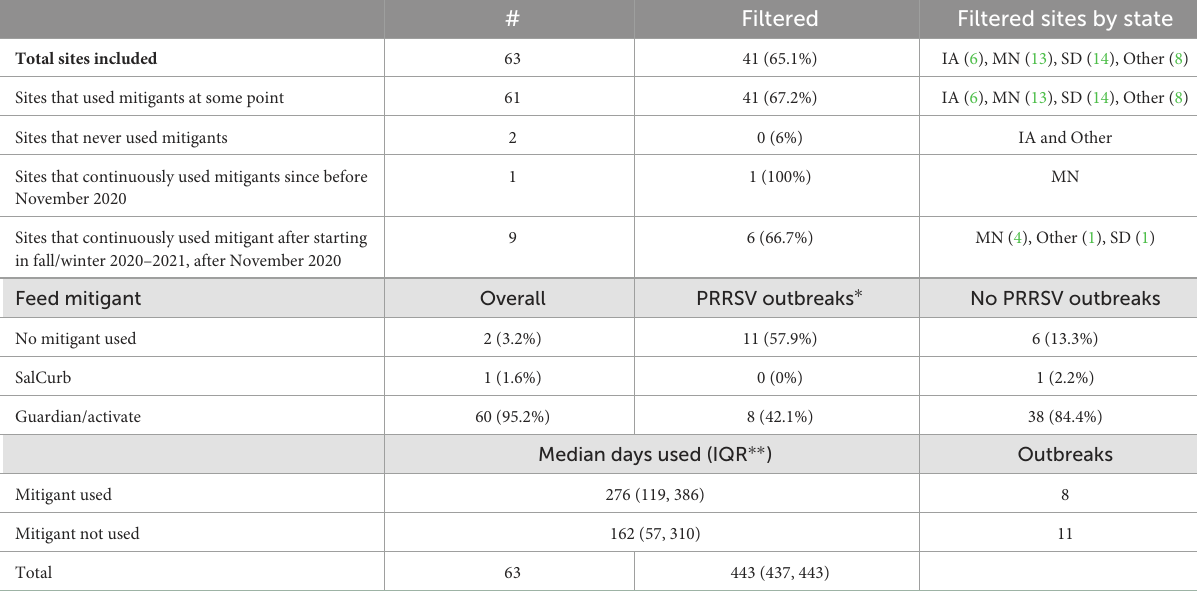
TABLE 3 Descriptive summary of PRRSV outbreaks, as well as feed mitigant and filter used by farrow-to-wean farms in the Pipestone Management System from November 2020 to January